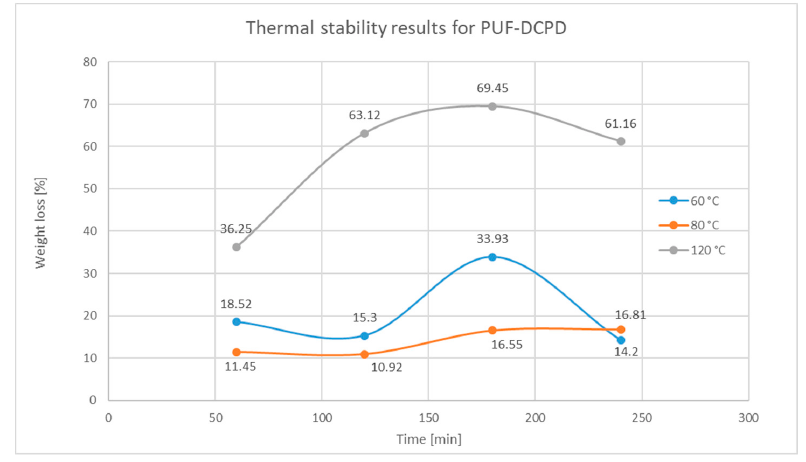
Figure 21. Weight loss variation over time for PUF-DCPD after thermal exposure at 60, 80, and 120 °C.